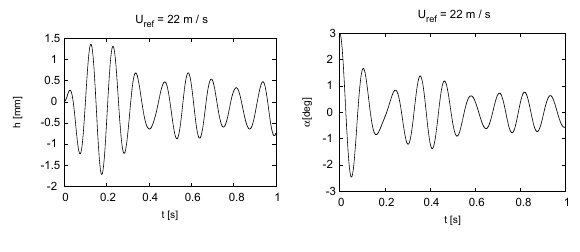
Fig. 13. Aeroelastic response for the seconde considered case in terms of h and α in time domain for far field velocity U ∞ = 22 m / s